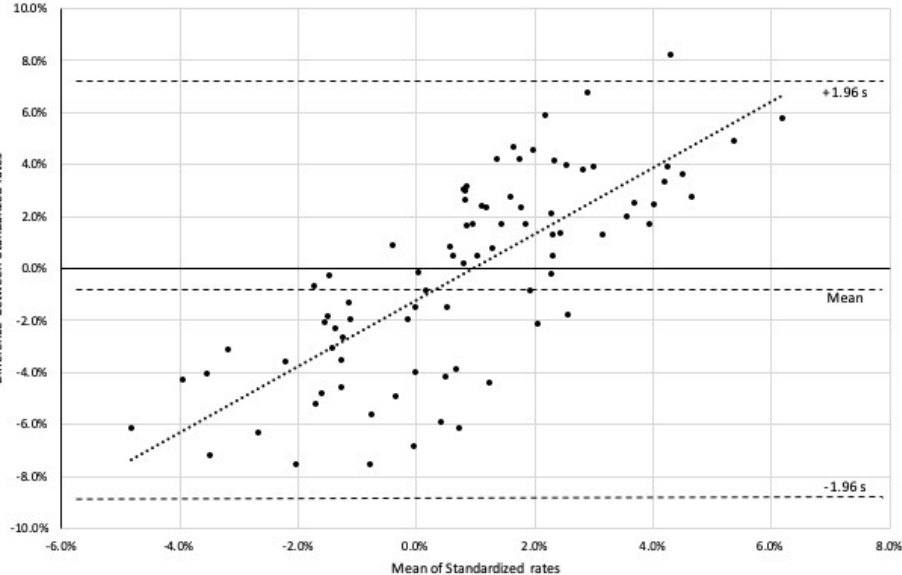
Figure 3. Bland–Altman diagram for deference between standardized rates (mean = − 0.16%, standard deviation (s) = 3.76%) Dotted line represents the regression line (y = 1.2714x − 0.0119).